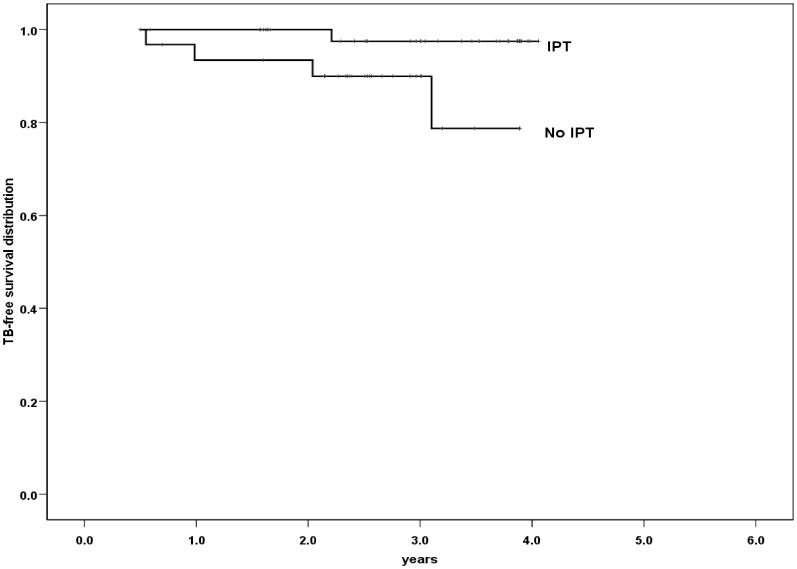
Risk for active TB among patients with dual positive results of TST and T-SPOT.TB stratified by receiving IPT or not.The TB incidence was 4.9 case per 100 PY for participants without IPT vs. 0.66 case per 100 PY for participants received IPT, p<0.05 by log-rank test. TST =  tuberculin skin test; IPT = isoniazid preventive therapy.